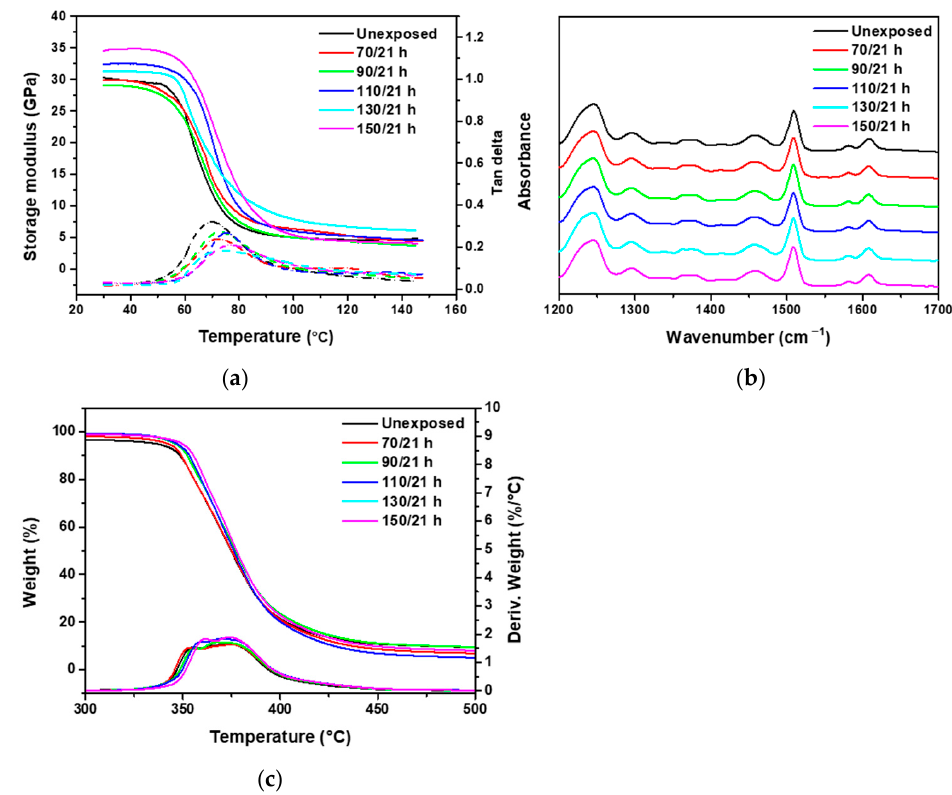
Figure 6. Effects of LEO exposure on CF-SMPCs: ( a ) thermomechanical behavior, ( b ) FT-IR spectra, and ( c ) TGA/DTA curve of LEO-exposed CF-SMPCs.